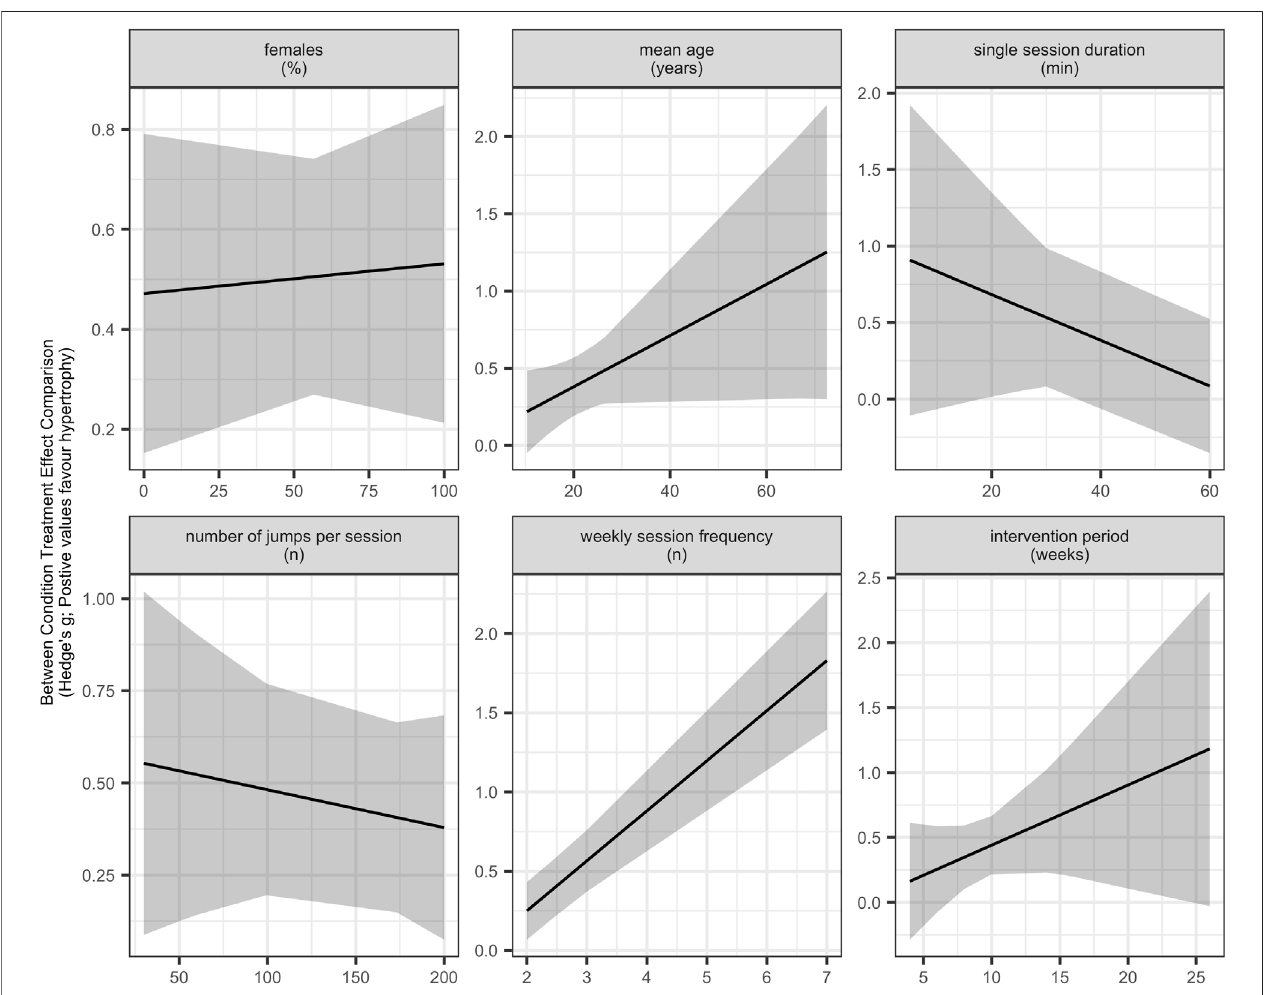
FIGURE 5 | Meta-analytic plots of continuous subgroups on skeletal muscle